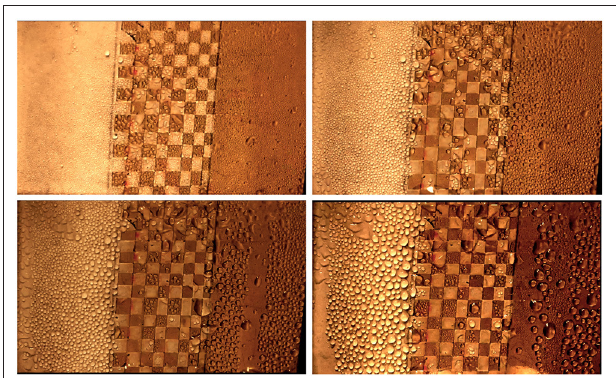
FIGURE 5 | The comparison of time evolution of condensation process on hydrophobic (left) , 2mm biphilic (center), and hydrophilic (right) regions. The images are taken every 10min. The biphilic substrate shows better droplet nucleation and removal throughout the experiment. The experimental parameters are: T sat 20 ◦ C, T w 10 ◦ C, humidity 80%RH, γ 2mm, = = − = = hydrophobic θ a and θ r are 150 ◦ and 144 ◦ , and hydrophilic θ a and θ r are 73 ◦ and 34 ◦ . The complete videos of the experiments are presented in Supplementary Information